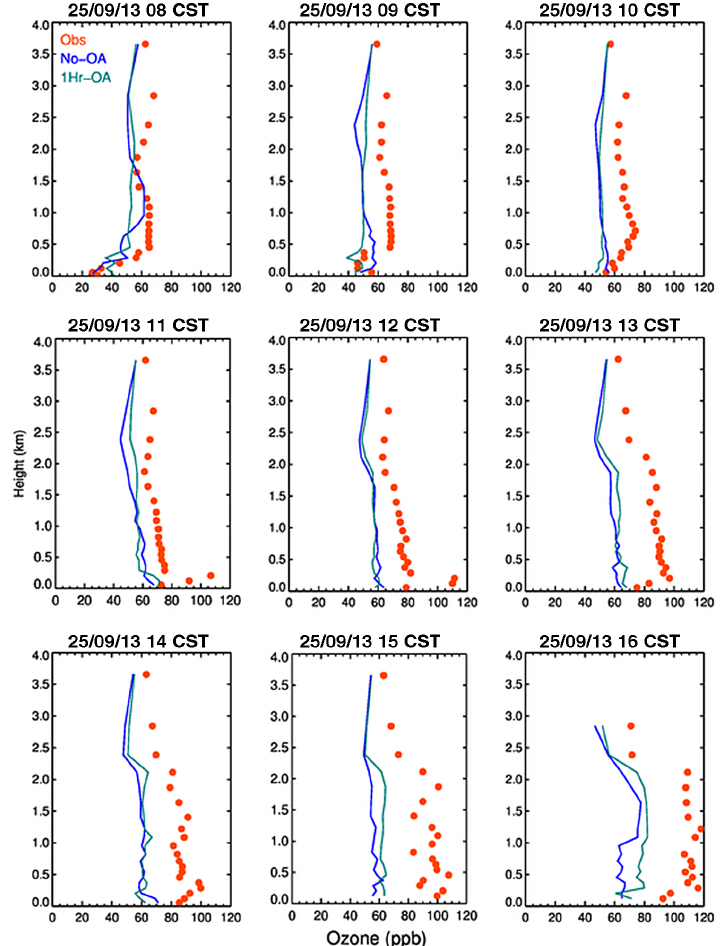
Figure 13. Vertical ozone profiles from 08:00 to 16:00CST on 25 September 2013 for two cases of No-OA and 1Hr-OA compared with corresponding observations. There are nine plots, each for 1h, with date and hour as